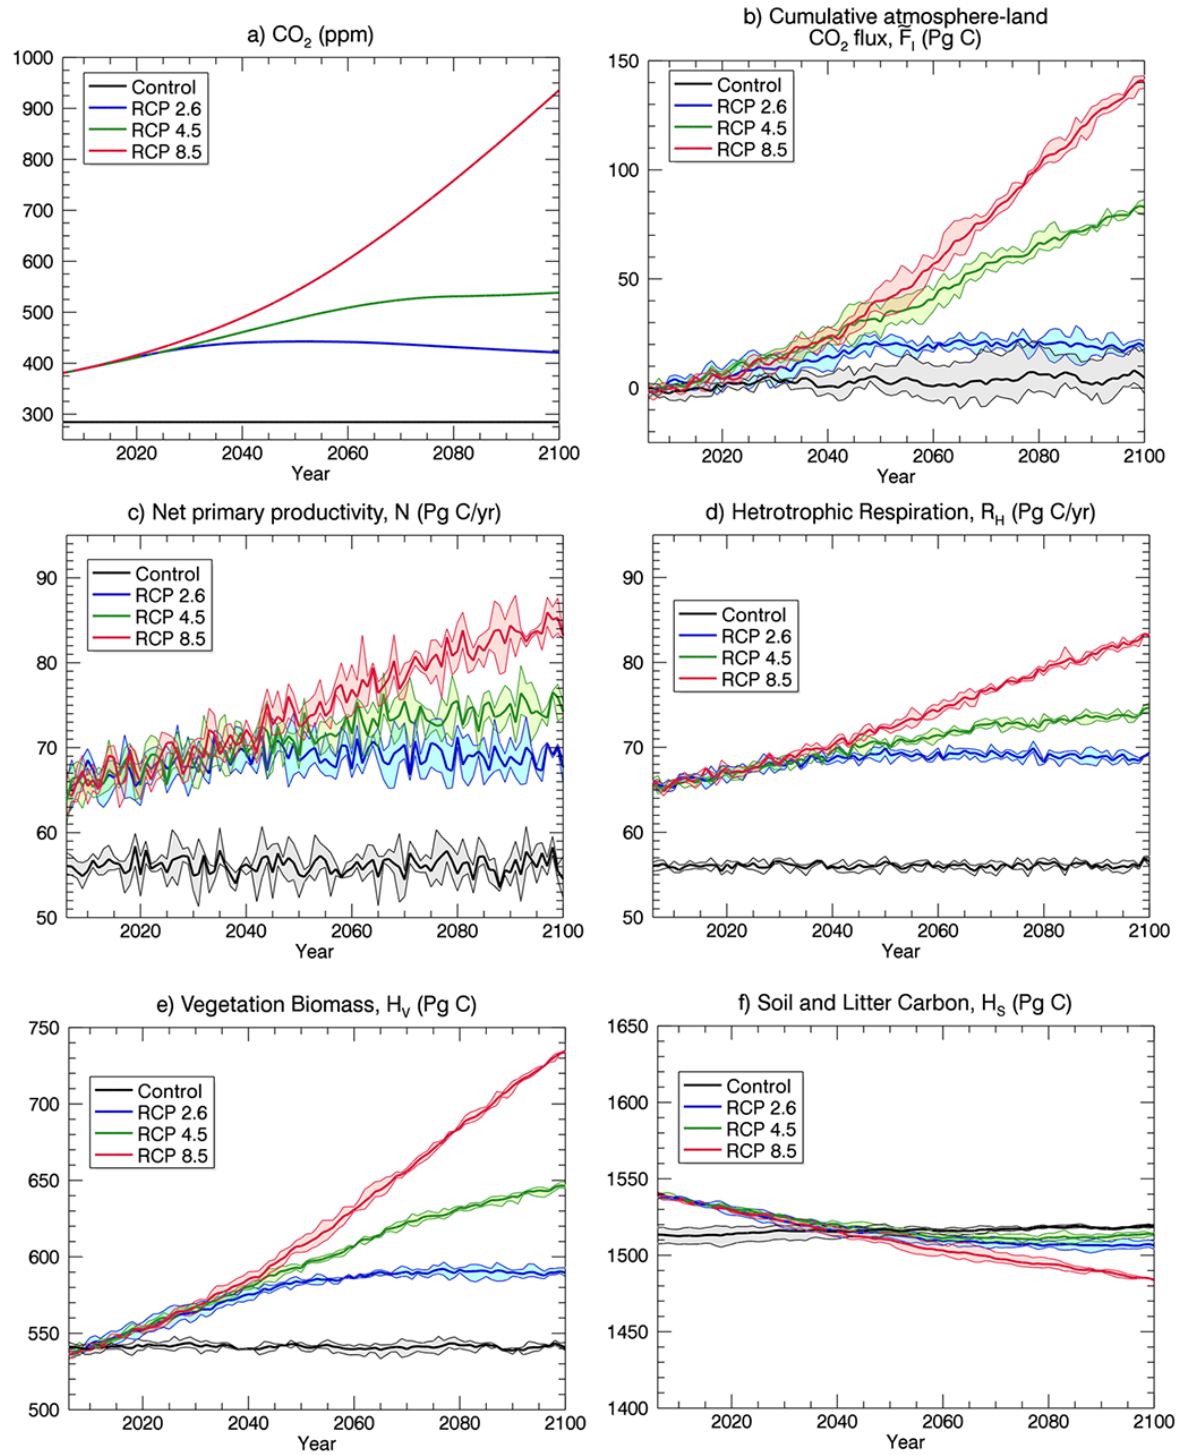
Figure 1. (a) Specified CO 2 concentrations used for the pre-industrial control and the three RCP-based simulations; (b) simulated cumulative atmosphere–land CO 2 uptake, ˜ F l = 1H l ; (c) terrestrial net primary productivity, N ; (d) heterotrophic respiration, R H ; (e) vegetation biomass, H V ; and (f) soil plus litter carbon, H S . The shading indicates the range in the variables across the three ensemble members of the simulations. The y -axis range is the same in panels (e) and (f)